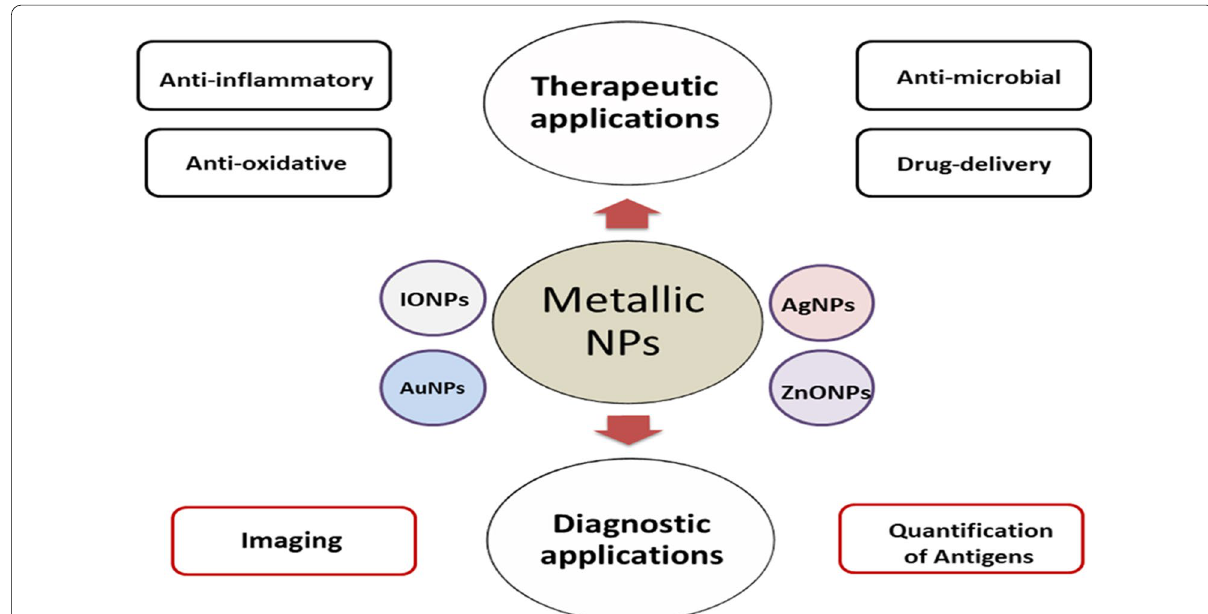
Fig. 1 Theranostics applications of metallic nanoparticles (NPs). Metal-based NPs exhibit several therapeutic benefits including anti-microbial (e.g. anti-viral), anti-oxidative, and anti-inflammatory activities. Metallic NPs could serve as drug carriers to deliver therapeutic agents or as diagnostic tools to enable noninvasive imaging or detection of